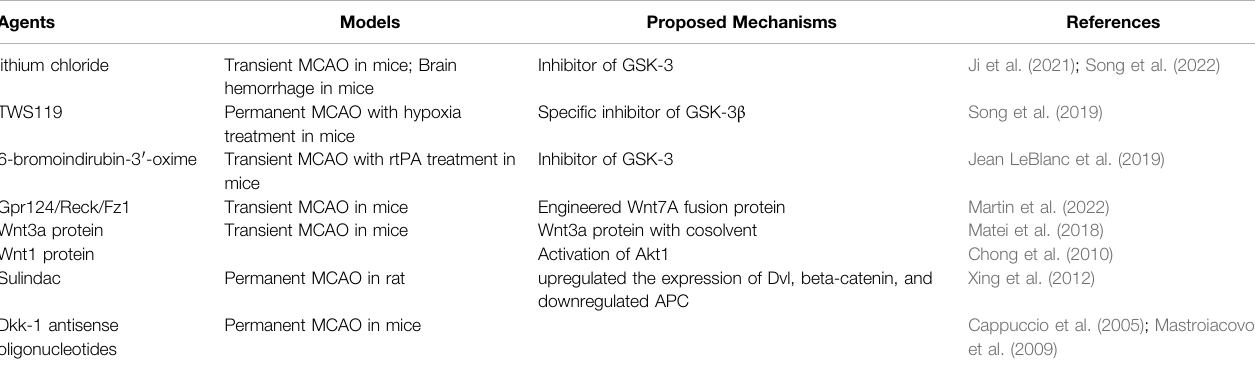
TABLE 1 | Pharmacological agents target Wnt/ β -catenin in experimental stroke.